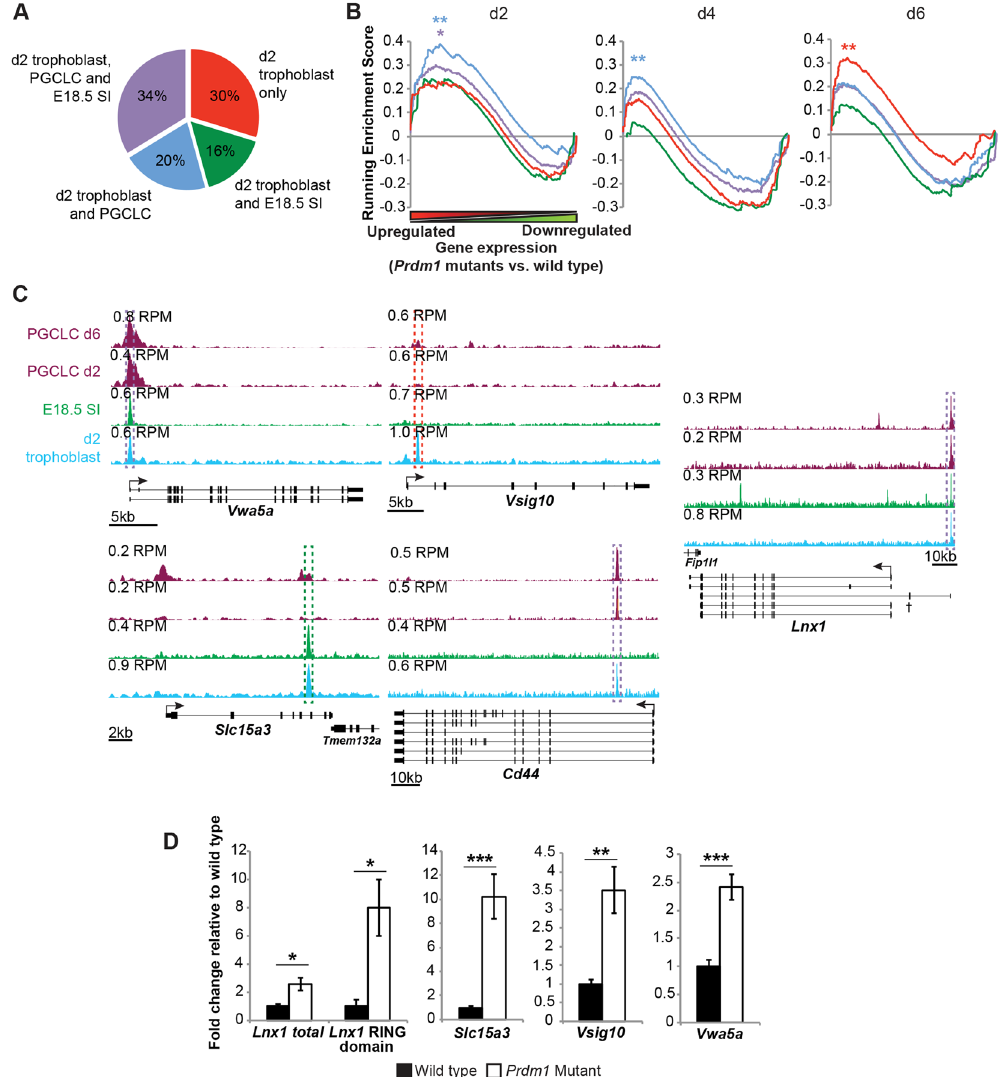
( B ) Gene Set Enrichment Analysis of wild type and Prdm1 mutant trophoblast gene expression profiles at day 2, 4 and 6 of differentiation in comparison with Blimp1 ChIP-seq peaks (nearest TSS ± 100 kb) categorized as in A. * P ≤ 5 × 10 − 3 , FWER P ≤ 5 × 10 − 2 ; ** P ≤ 1 × 10 − 3 , FWER P ≤ 1 × 10 − 3 . ( C ) ChIP-seq tracks showing peaks shared between different cell types ( Vwa5a , Slc15a3, Cd44 , Lnx1 ) or unique to d2 trophoblasts ( Vsig10 ). Peaks are boxed and colour-coded as in panel A. † = Lnx1 exon encoding the RING domain. ( D ) RT-qPCR validation of expression changes in wild type and Prdm1 mutant d2 trophoblasts. * P ≤ 5 × 10 − 3 ; ** P ≤ 1 × 10 − 3 ; *** P ≤ 3 × 10 − 5 . Data represents means ± S.E.M., n ≥ 9 per